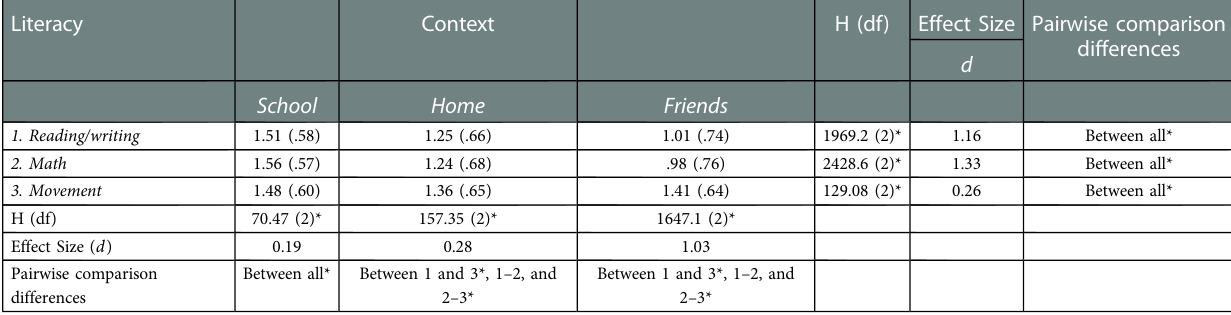
TABLE 1 Overall and pairwise differences between literacies and contexts (Mean, SD). Effect sizes are listed for signi fi cant overall differences. Literacy